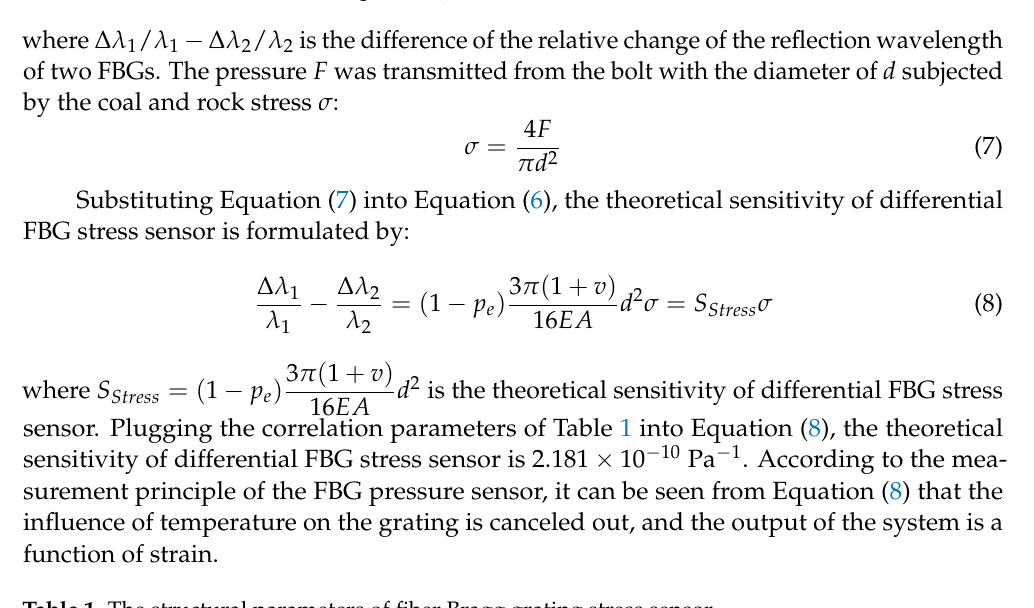
Table 1. The structural parameters of fiber Bragg grating stress